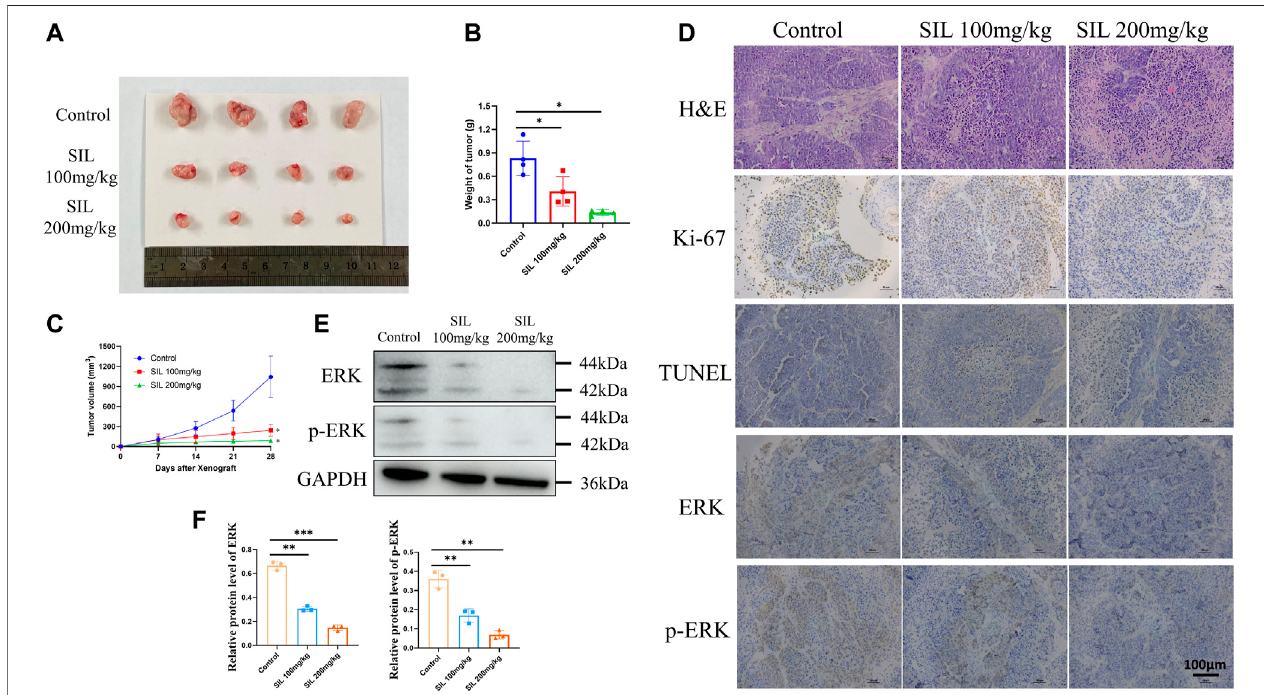
FIGURE7| Silibininsuppressedtumorgrowthinthecholangiocarcinomaxenograftmodel. (A) .Anti-tumoractivityofsilibininintumor-bearingmice.Representative xenografts areshown. (B) .Tumorweights ofeach groupmeasured attheendoftreatment.Dataareshownasmean±SD, * p < 0.05 ,signi fi cantlydifferentcompared to the control group. (C) . Tumor volumes of each group are measured in the indicated days of treatment. * p < 0.05 meant a signi fi cant difference compared to the control group at the end of the treatment. (D) . H&E, Ki-67 and immunohistochemistry assays of cholangiocarcinoma tissue. (E,F) . The expression of ERK and p-ERK proteinswasdetected invivo, andquanti fi cationresultsareshownbyhistograms.Dataisshownasmean±SD,** p < 0.01 ,*** p < 0.001 ,signi fi cantlydifferentcompared to the control